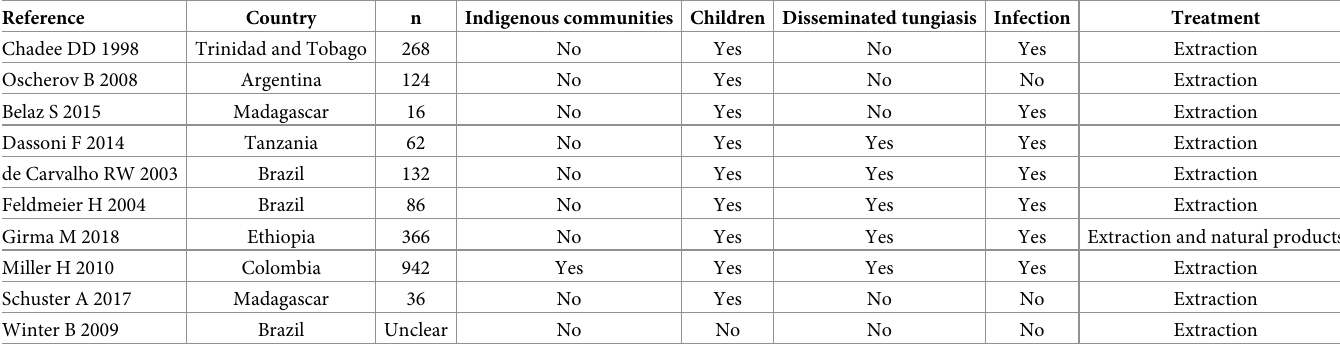
Table 2. Study characteristics of the included observational studies.